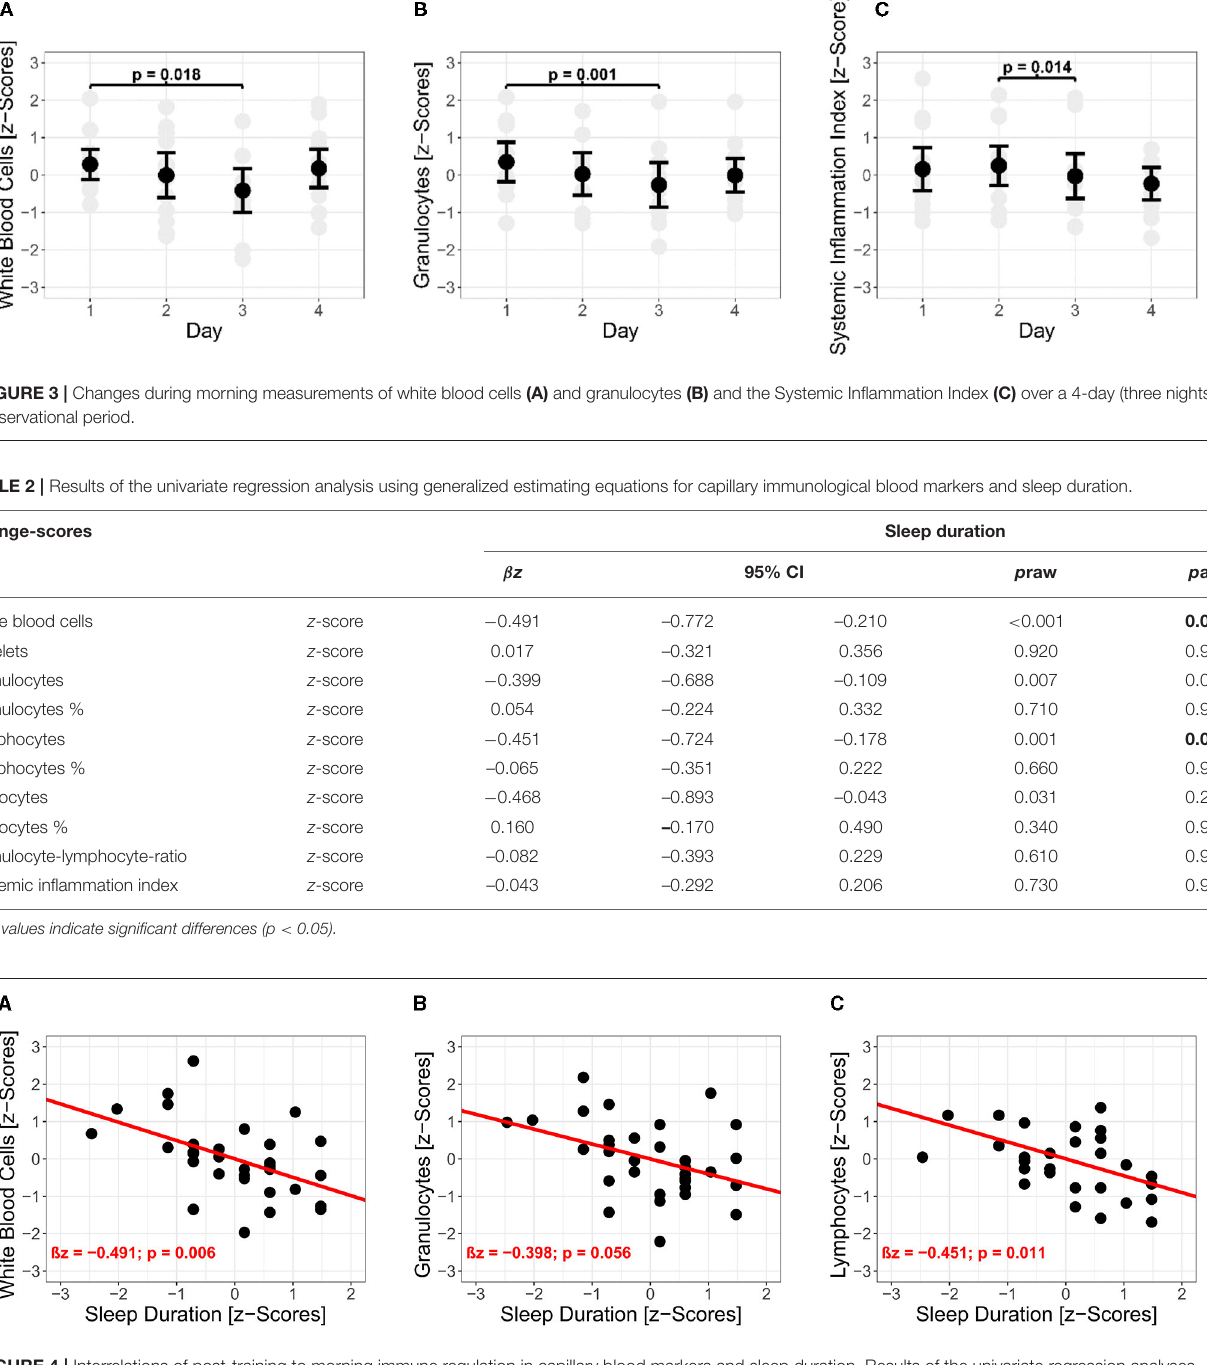
decrease after 1 day of training, whereas a significant decrease was found after 2 days of training compared to the first